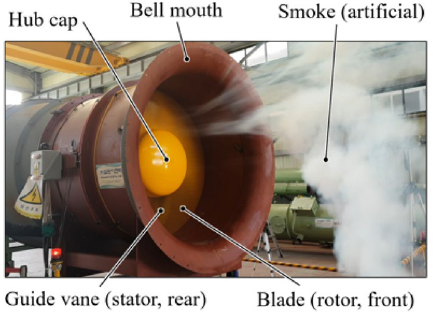
Figure 1. Typical assembly of an axial fan.